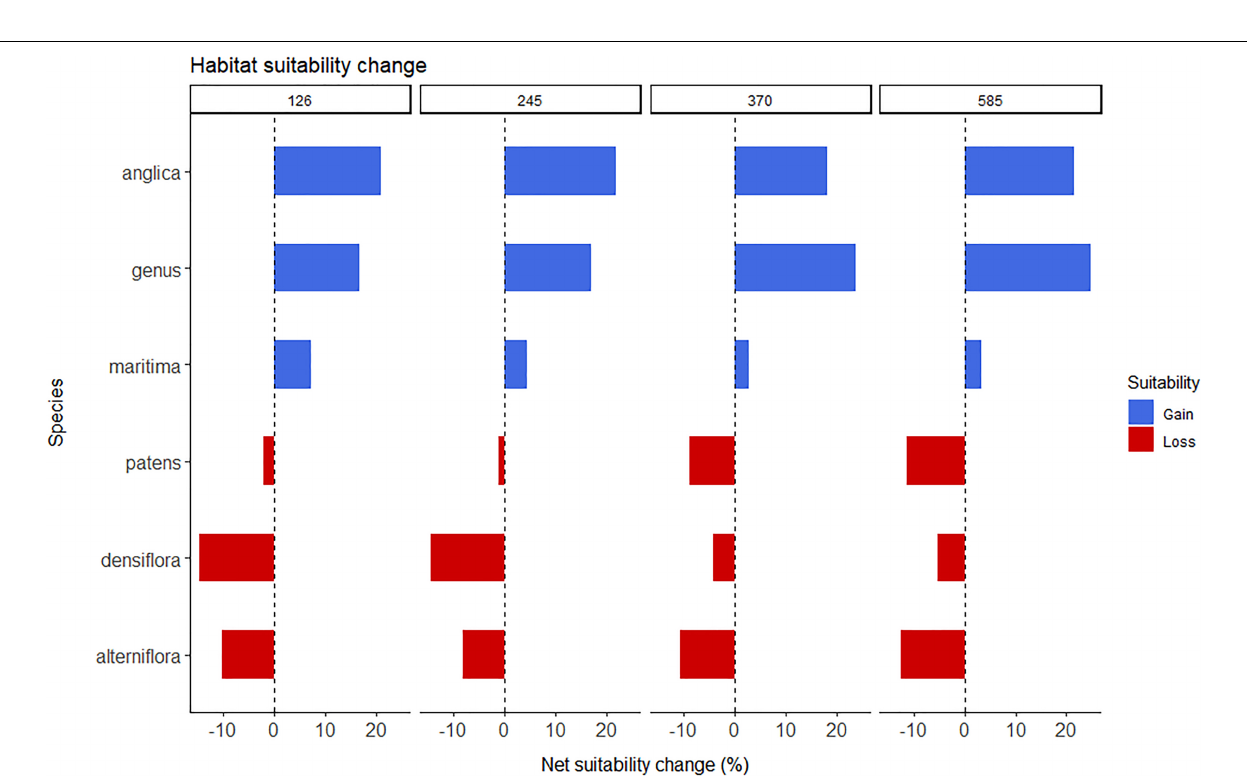
FIGURE 3 | Net change in habitat suitability (%) until 2100, calculated from the difference between each species’ percentage gain and percentage loss in suitability between the 2081 and 2100 and the historical time periods for each CMIP6 Shared Socioeconomic pathway (i.e., SSP1-2.6, 2-4.5, 3-7.0, and 5-8.5). Presented values refer to each Spartina spp. species (i.e., S. alterniflora , S. anglica , S. densiflora , S. maritima , and S. patens ) and for the whole genus.